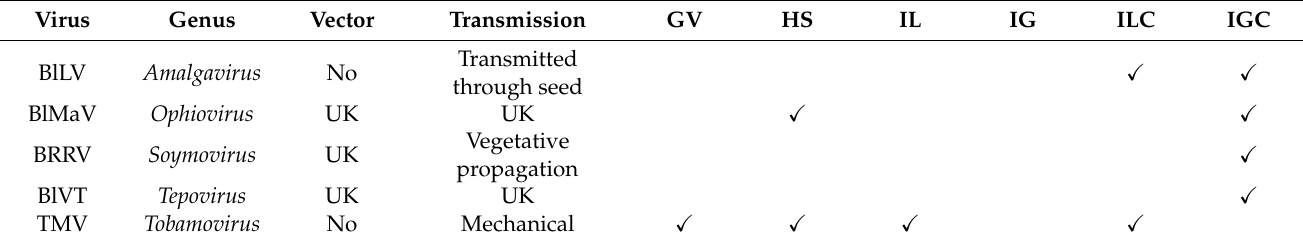
BlMaV, blueberry mosaic associated ophiovirus; BlLV, blueberry latent virus; BRRV, blueberry red ringspot virus; BlVT, blueberry virus T; TMV, tobacco mosaic virus; UK, unknown vector; GV, Gainesville; HS, High Springs; IG, Island Grove; IL, Interlachen; ILC, Interlachen cultivated site; IGC, Island Grove cultivated